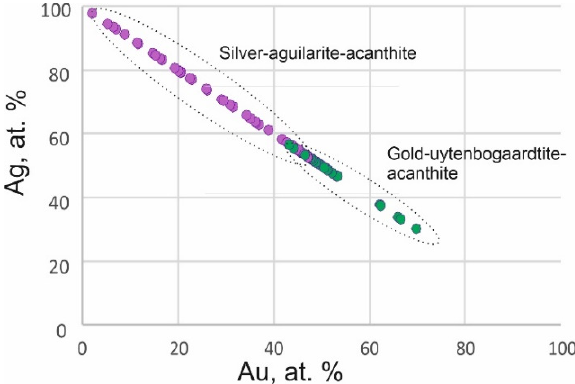
Figure 4. Variations in the compositions of Au-Ag alloys from the Rodnikovoe deposit, showing the main two established assemblages (sub-stages).